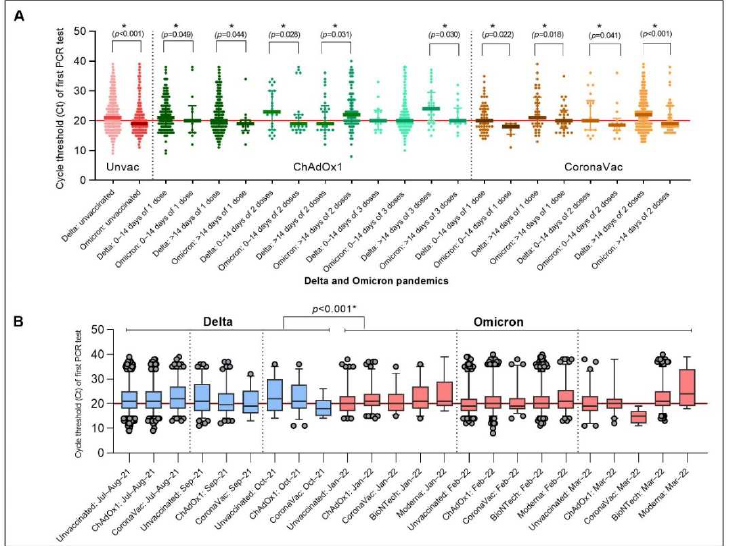
Figure 2. Ct value trajectories of confirmed COVID-19 infection and symptoms during the Delta and Omicron pandemics in vaccinated and unvaccinated individuals. ( A ) Ct values by vaccination/reinfection status and ( B ) Ct values by waves and vaccination type. * p < 0.05.